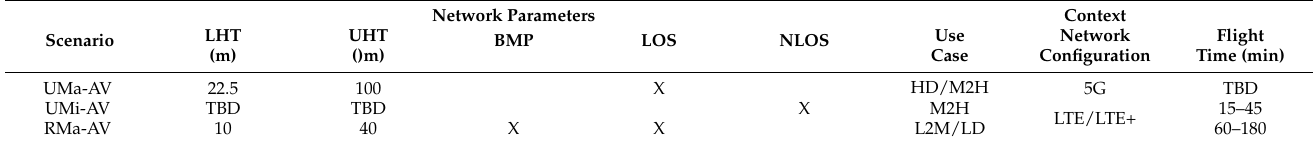
Table 2. Context-based Specifications for UAV